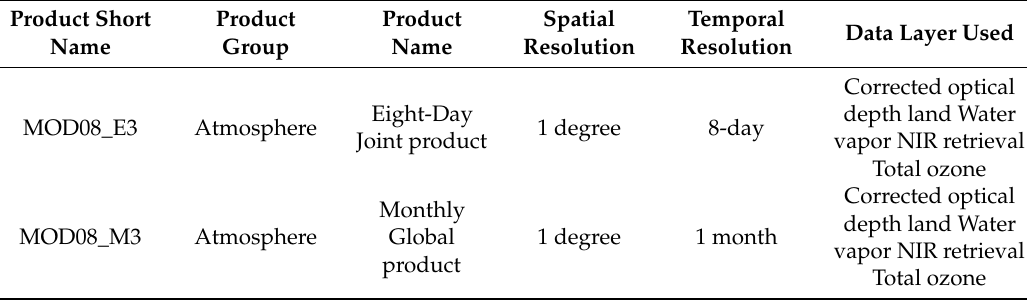
Table 2. MODIS data products level 3 used for the daily products gap